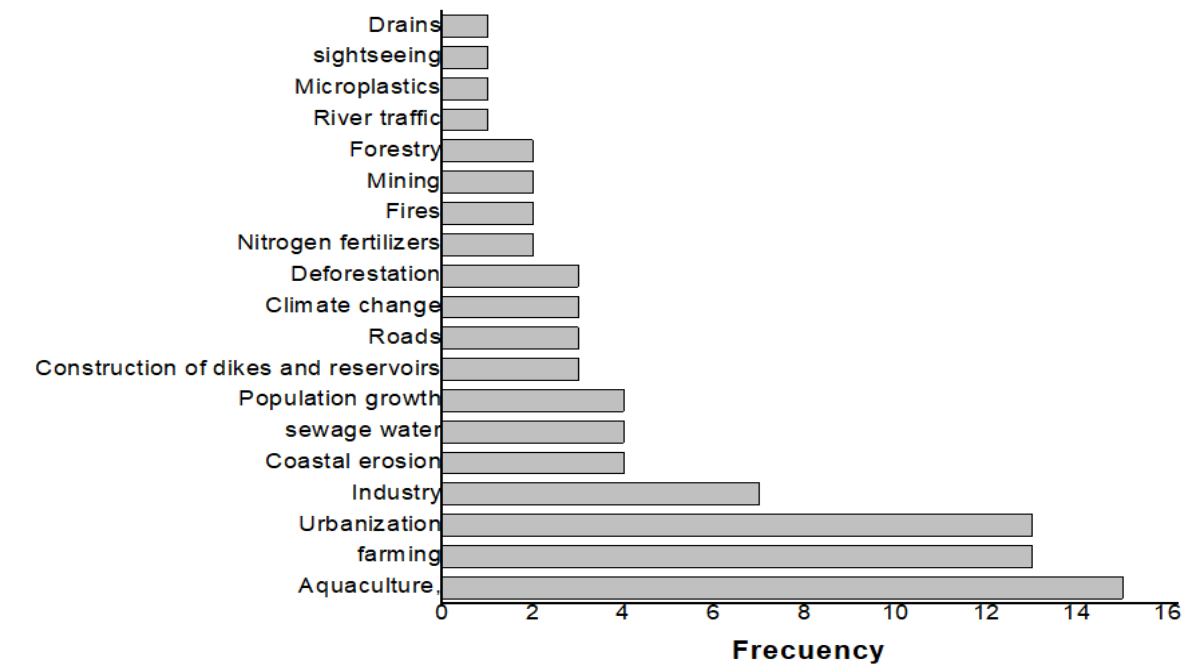
Figure 7. Frequency distribution of incident factors that affect wetlands in Asia.